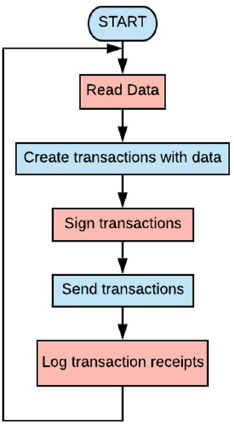
Figure 2. Steps performed by Python script at the Raspberry Pi IoT device.